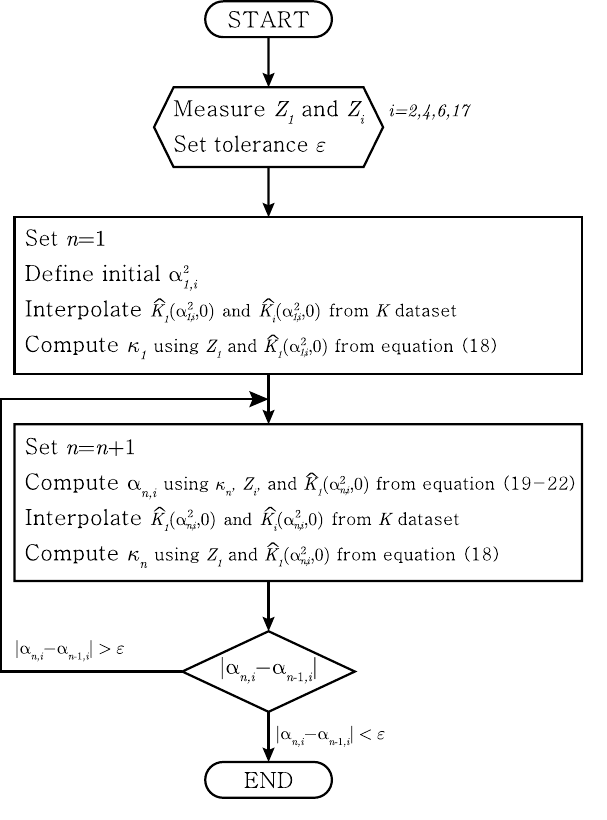
Figure 5. Iteration scheme of the method